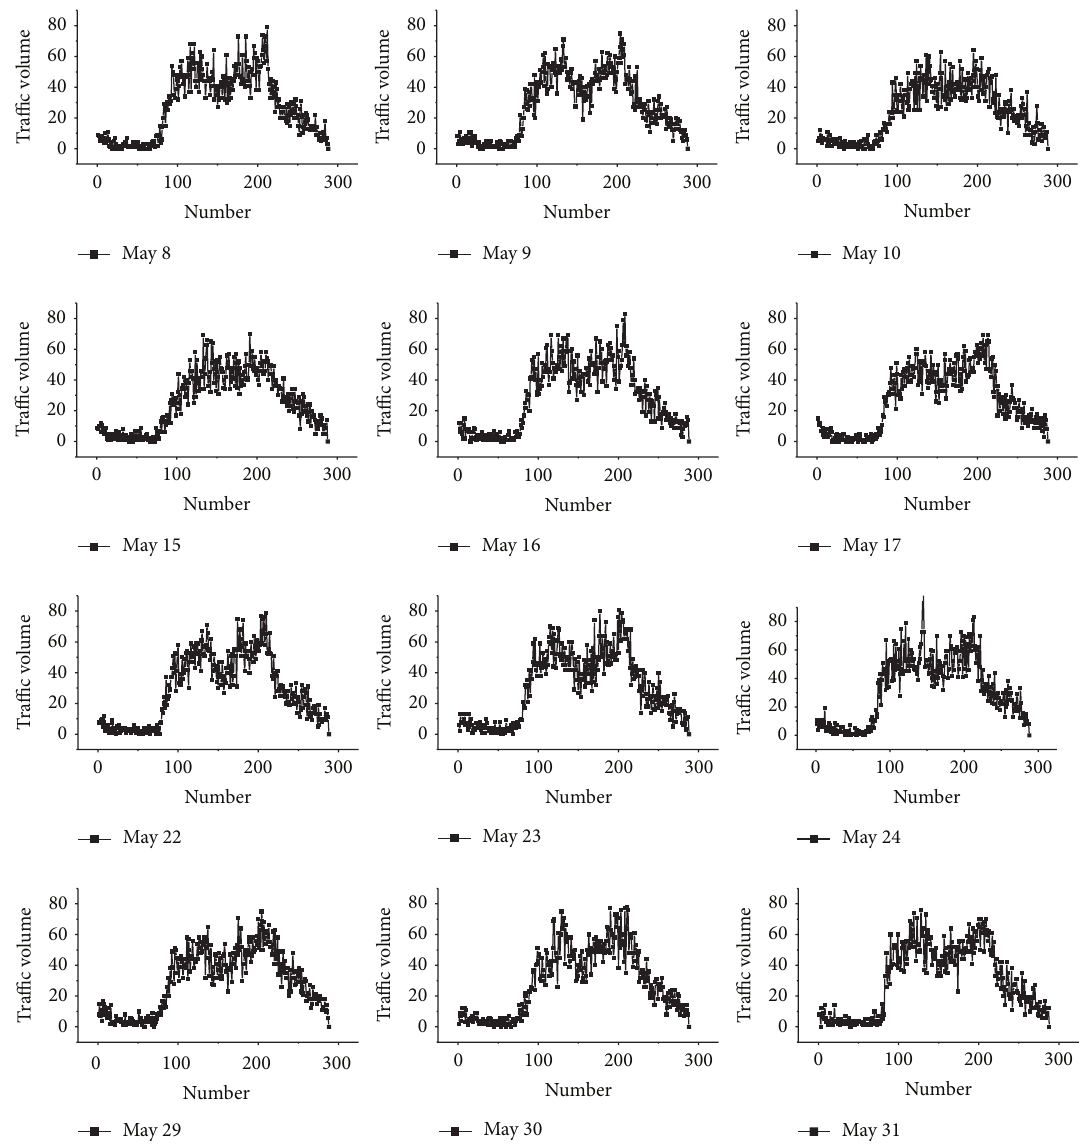
Figure 2: Traffic volume data for 5-minute intervals from May,